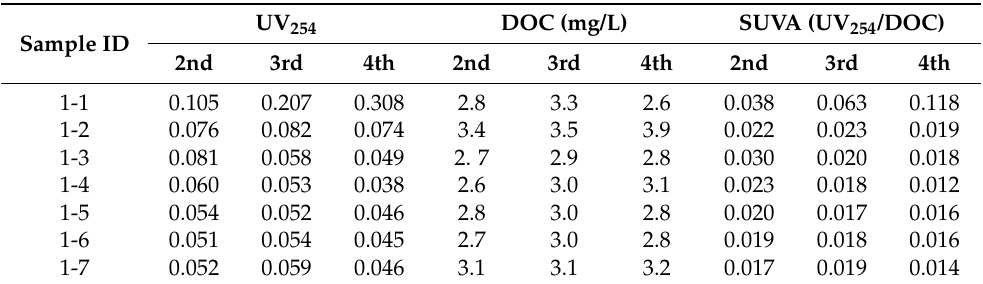
Table 2. Measurements of UV 254 , dissolved organic matter (DOC), and specific UV absorbance (SUVA) in the waters collected in System I.